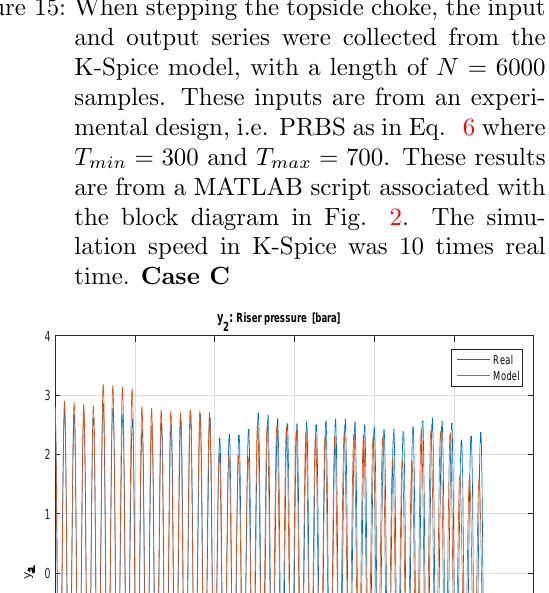
Figure 17: Comparing closed loop controllers: PI ( K p = − 10 , T i = 60 , T d = 0) and LQR ( Q = 1 , P = 10). The controllers are in- troduced at Time = 500 Samples.